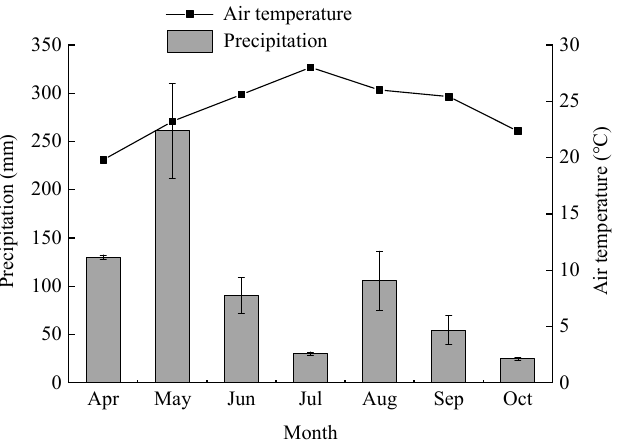
Figure 1. Monthly average air temperature and precipitation during the experiment. Each column represents the average value of three replicates ( n = 3). Error bars represent standard errors (SE) .